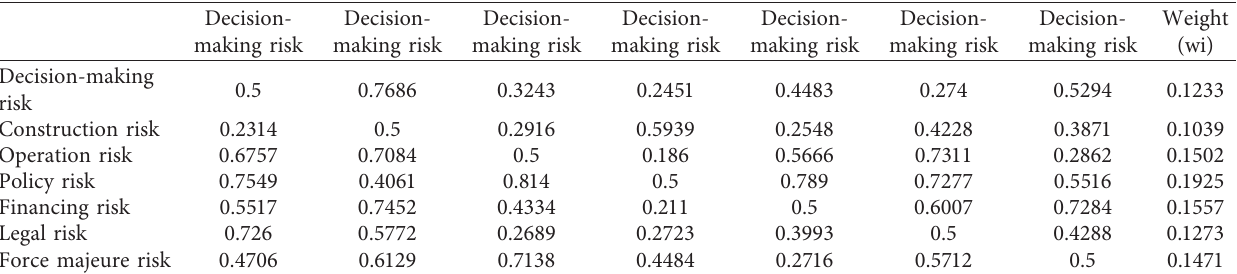
Table 3: Fuzzy judgment matrix of criterion layer.